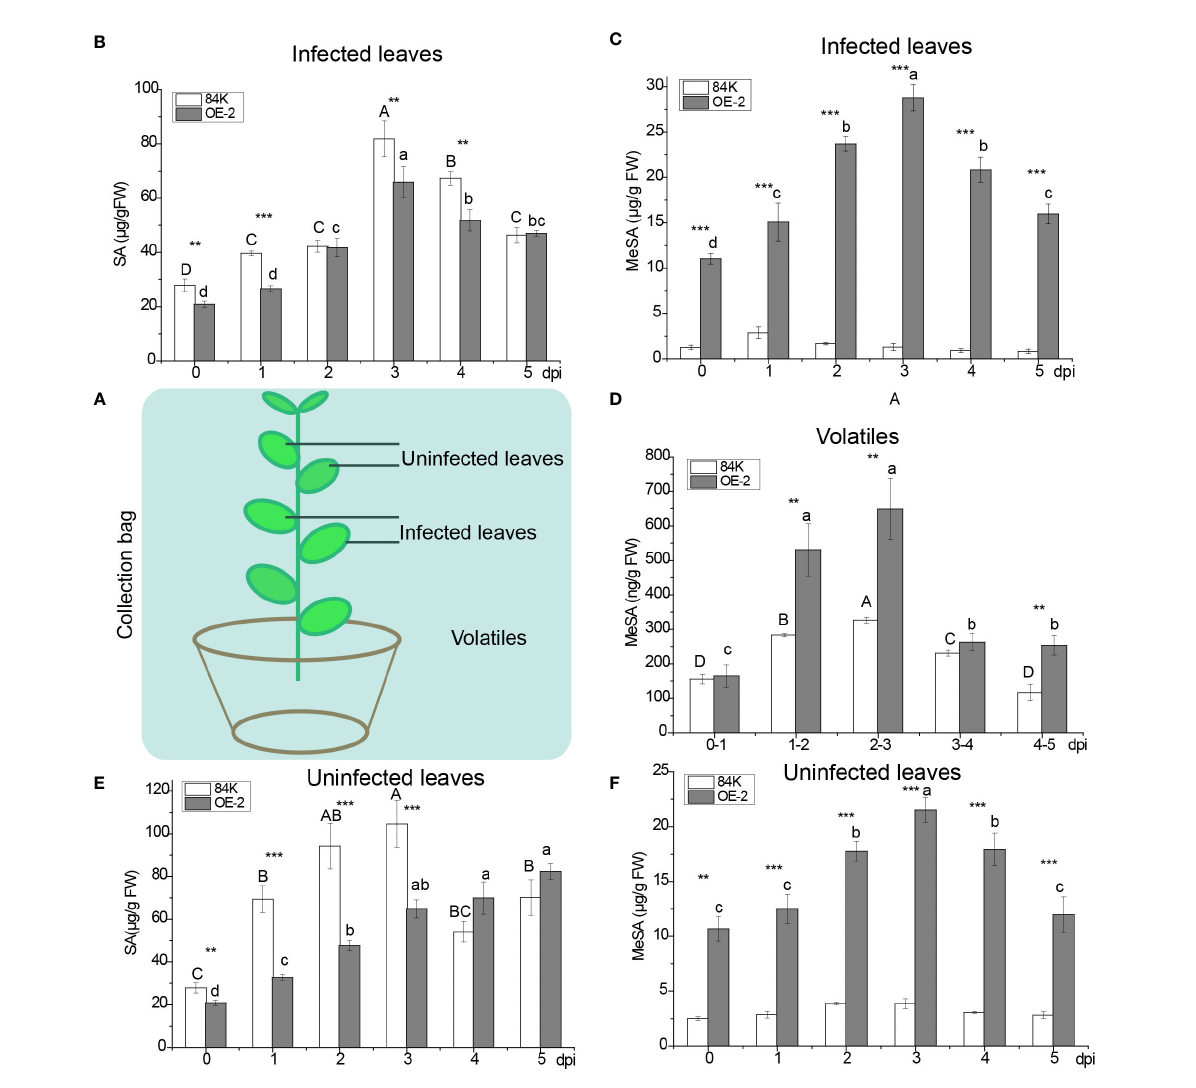
FIGURE 3 Quanti fi cation of MeSA and SA in infected and noninfected sites during pathogen inoculation. (A) Schematic diagram of infected and noninfected leaves of poplar. (B) SA levels in OE-2 and wild-type plants in infected leaves. (C) MeSA levels in OE-2 and wild-type plants in infected leaves. (D) Emission of MeSA from plants. (E) SA levels in OE-2 and wild-type plants in uninfected leaves. (F) MeSA levels in OE-2 and wild-type plants in uninfected leaves. Mean values from three independent plants are given. dpi, days past inoculation. Each bar represents the mean relative expression level of three independent experiments with the standard errors. The bars with asterisks indicate signi fi cant differences between the 84K and OE-2 lines at the same time (** p<0.01 ; *** p<0.001 ). The uppercase letters are the statistical differences of measured data with respect to the time series of the 84K line, p<0.05 . The lowercase letters are the statistical differences of measured data during the time series of the OE-2 line, p<0.05